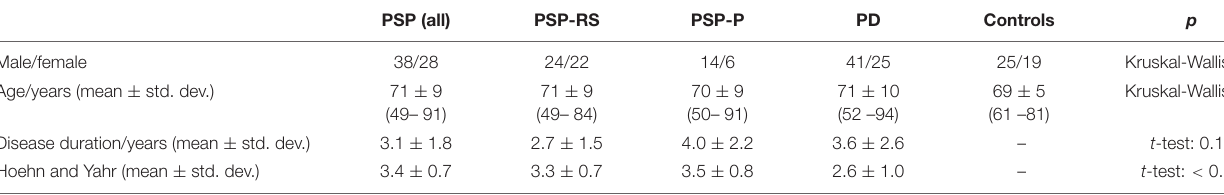
TABLE 1 | Subjects’